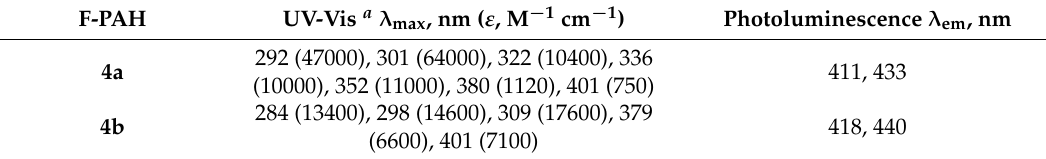
Figure 2. UV-Vis ( A ) and photoluminescence ( B ) spectra of 4a (blue line) and 4b (red line) in CH 2 Cl 2 . Table 1. UV-Vis and photoluminescence spectral data of 4a and 4b a